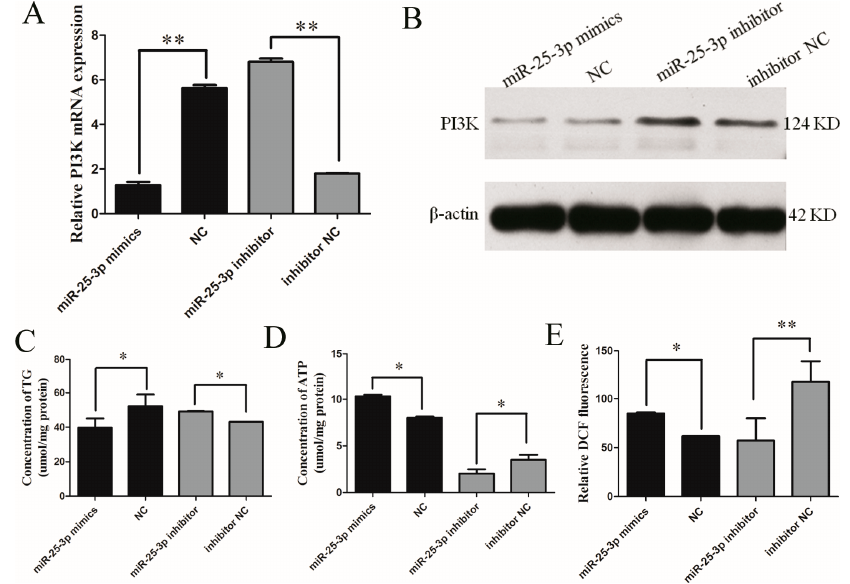
Figure 2. The effect of miR-25 on the metabolism of C2C12 cells. miR-25-3p mimics/NC or inhibitors/NC were respectively transfected into growing C2C12 cells. After 48 h, PI3K expression was detected by qRT-PCR ( A ) and Western blotting ( B ). After 24–48 h transfection, the levels of triglyceride (TG) ( C ), ATP ( D ), and reactive oxygen species (ROS) ( E ) were measured with commercial kits. The fluorescence of DCF represents the content of ROS. NC = negative control (miR-239b-5p of caenorhabditis elegans). β -actin served as the loading control. Data were presented as means ± SD ( n ≥ 3); * p < 0.05; ** p < 0.01.